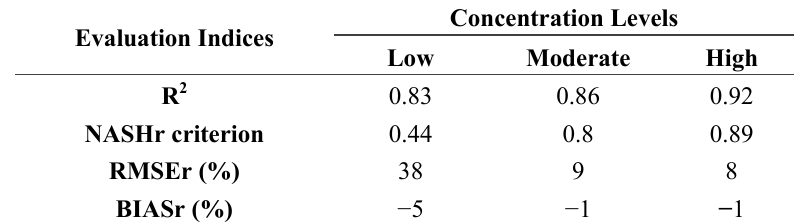
Table 4. Evaluation of the three models ( estimators ) using cross-validation